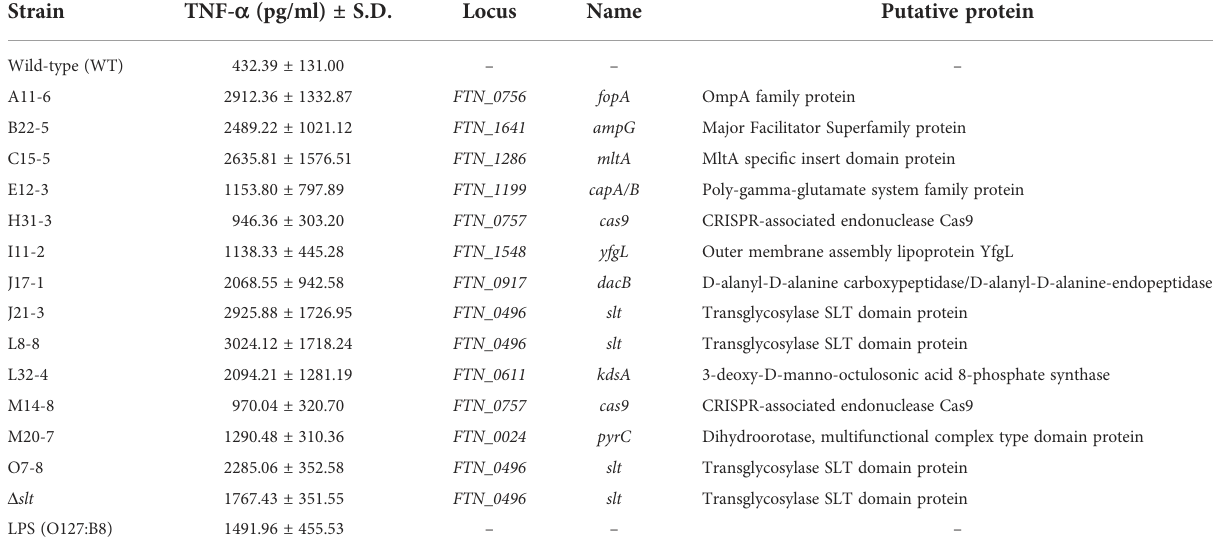
TABLE 1 The results of screening and sequence analysis of transposon mutants. Strain TNF- a (pg/ml) ± S.D.